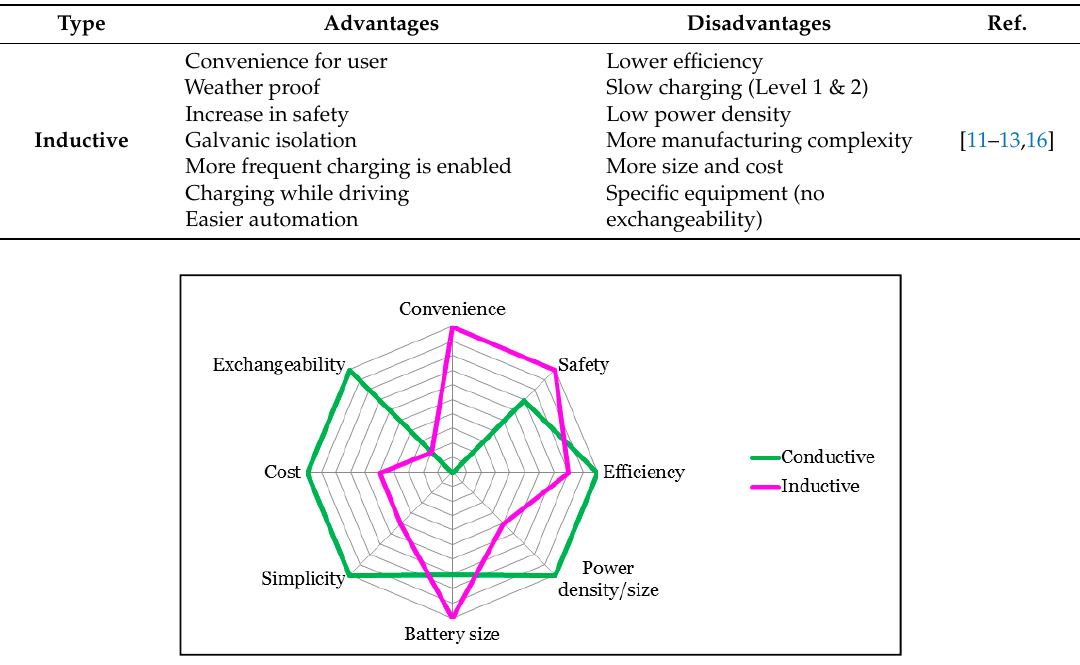
Figure 3. Comparison between conductive and inductive chargers.